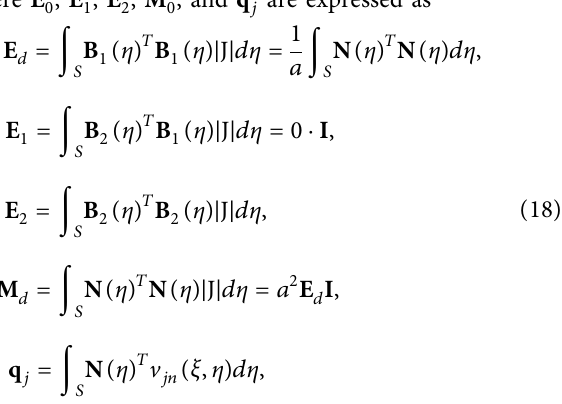
Figure 7: The time history of the displacement at z � h excited by wave forces.